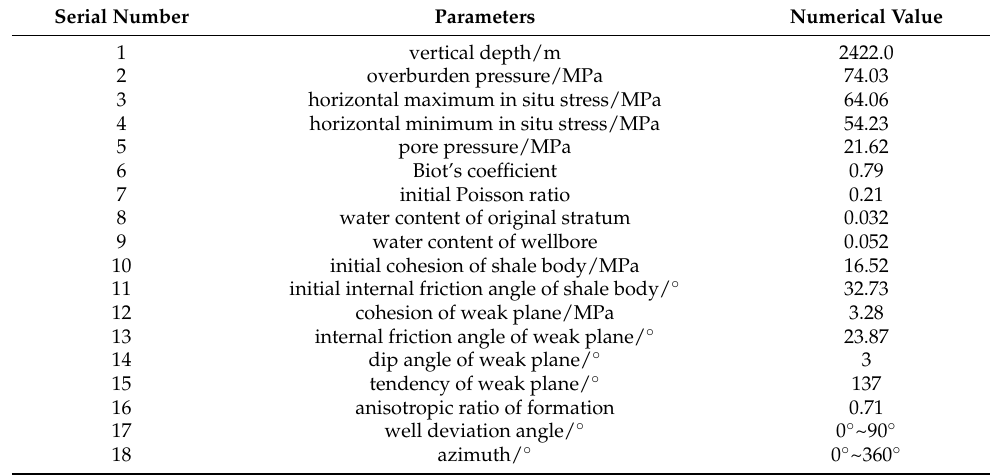
Table 1. Basic stratigraphic parameters of continental shale in Songliao Basin.